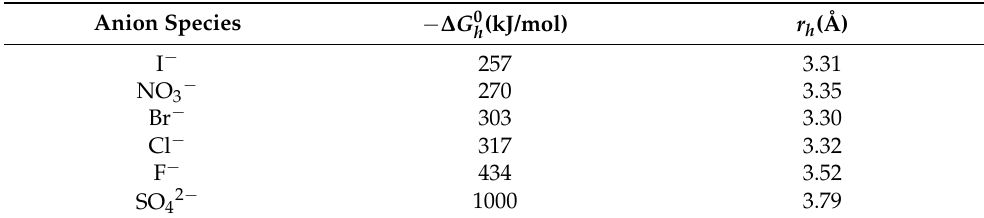
Table 1. Hydrated radii ( r h ) and Gibbs free energy of hydration ( − ∆ G 0 and SO 42 −